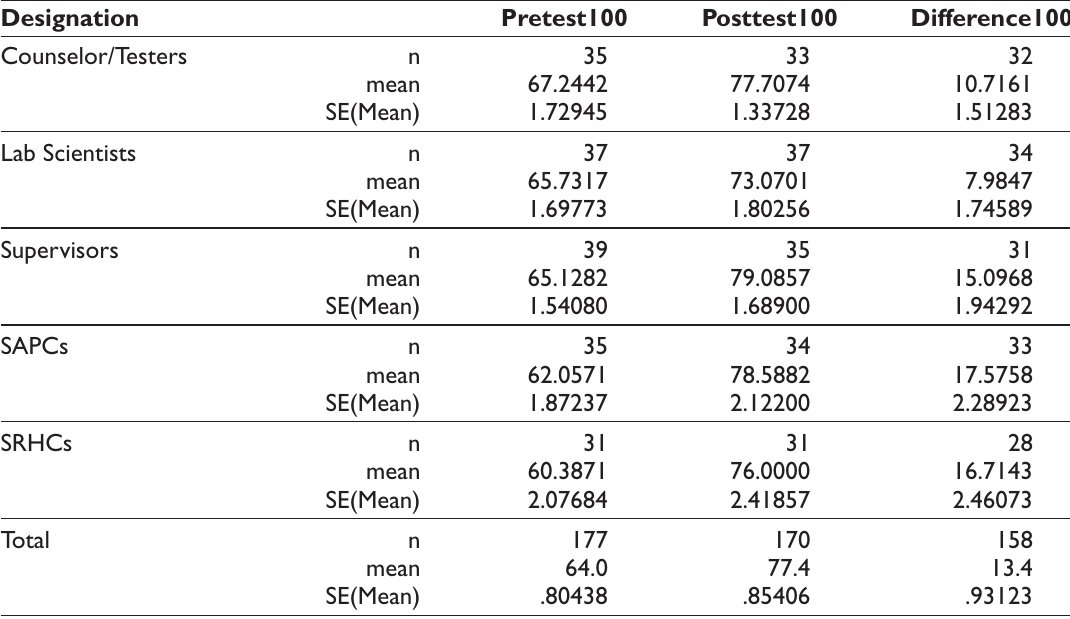
Distribution of Pre-test and Post-test Scores and Knowledge gain across the categories of the